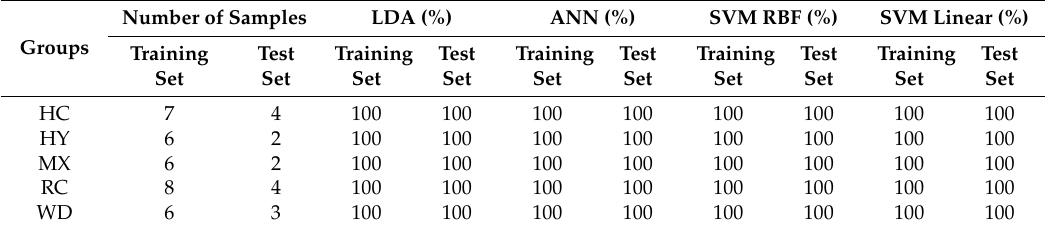
Table 4. Discrimination results (accuracy rate) of different models by electronic tongue.